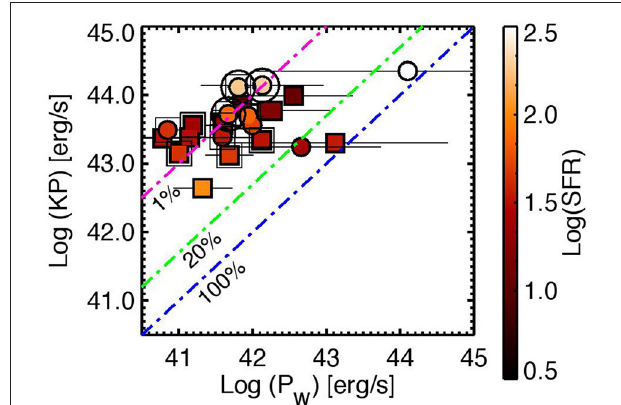
FIGURE 2 | Logarithm of kinetic power of the starburst associated to SNe (KP) as a function of the outflow power (Pw), color coded by their SFR. We identify pure starbursts and AGN-hosts with squares and circles, respectively, while very strong-AGN are marked with an additional circle. Those galaxies for which we were unable to infer in detail the outflow morphology are marked with an additional square. The pink, green and blue lines represent respectively the positions for which the power of the outflow is equal to the 1, 20, and 100% of the kinetic power supplied by the starburst. Credit: Cazzoli, A & A, 590, A125, 2016, reproduced with permission ©